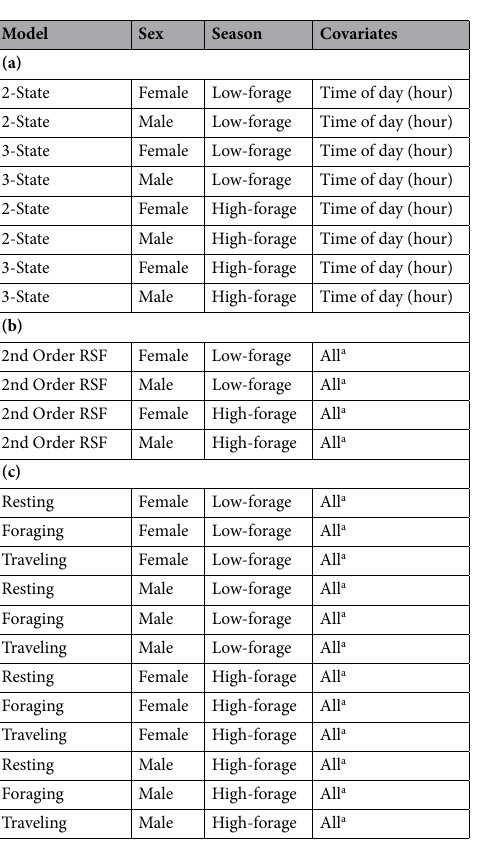
Table 2. A demonstration of all models ran for female and male wild pigs ( Sus scrofa ) on the Savannah River Site in South Carolina during two distinct seasons based on forage availability, low-forage availability (January–April) and high-forage availability (May–December) separated by type including: (a) hidden Markov models, (b) second order resource selection functions, and (c) third order resource selection functions. a All covariates includes distance to upland pines, distance to upland hardwoods, distance to streams, distance to shrub/herb, distance to secondary road, distance to primary road, distance to bottomland hardwoods, and percent canopy